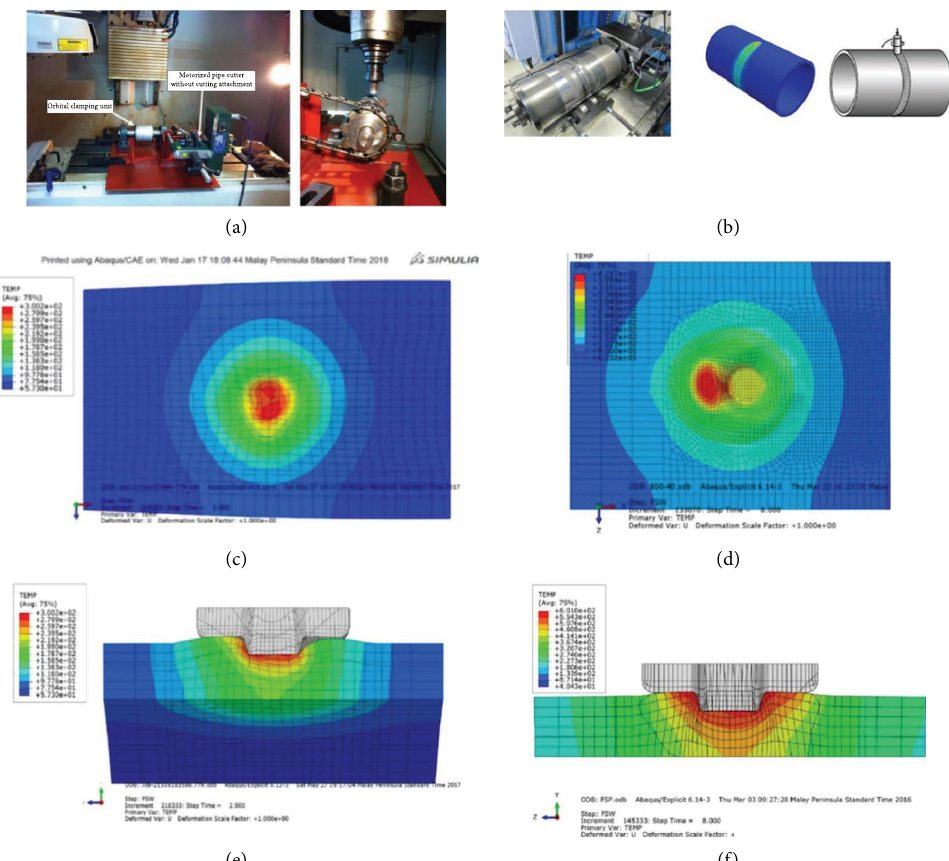
Figure 7: (a) An orbital clamping unit used for pipe welding [103] (b) a portable machine for FSW of pipes and a model image of the pipe, comparison between the models (top view) (c) curved and (d) fat models, cross-section comparison between the (e) linear and the (f) curved modes